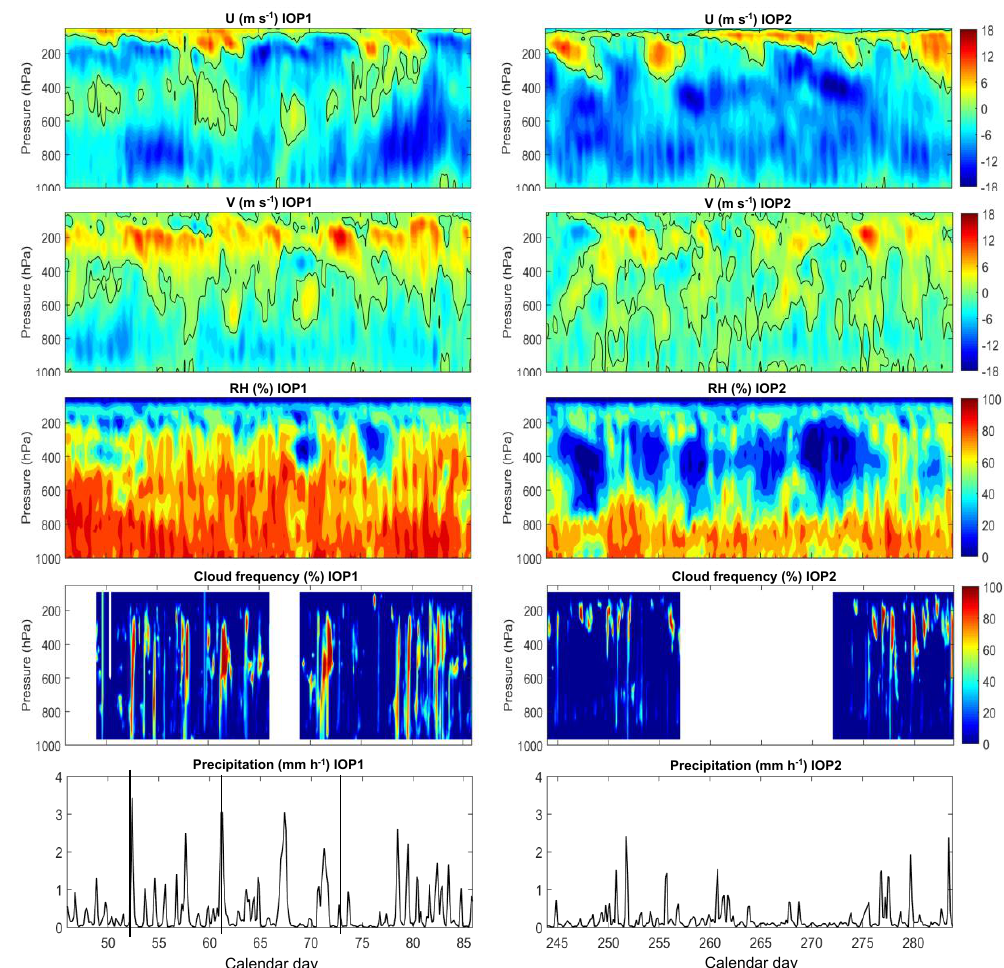
Figure 3. Domain-averaged time series of (from top to bottom) horizontal ( u ) wind, meridional ( v ) wind, relative humidity, cloud frequency (point observation at the ARM site) and precipitation for IOP1 (left) and IOP2 (right). The blank areas in cloud frequency indicate missing data. The three straight black lines in IOP1 show the three cases chosen in Sect.